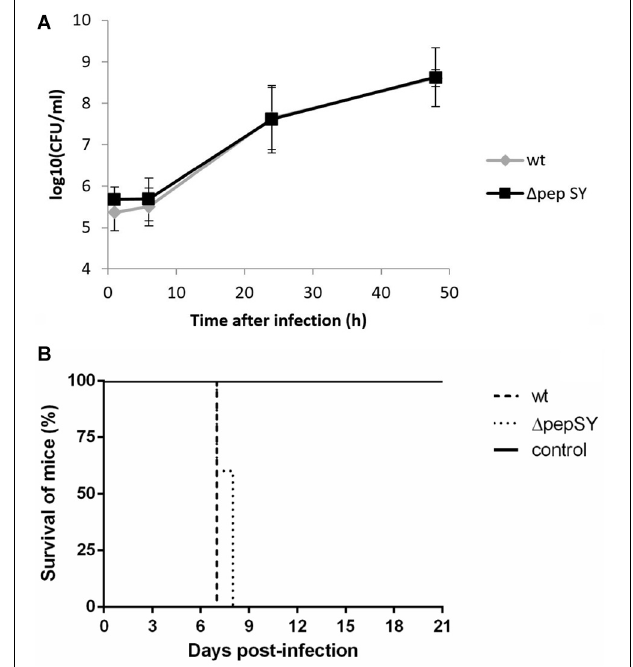
FIGURE 3 | Sensitivity of F. tularensis (cid:49) gapA , wtFSC200, and uvrA in to UV irradiation (A) and to H 2 O 2 (B) . For UV tolerance assay (A) , 10-fold serially diluted bacteria plated on McLeod agar were irradiated for various lengths of time under a 254 nm germicidal lamp. After UV irradiation the bacteria were cultivated at 37 ◦ C and the number of survivors was calculated by plate counts. For the uvrA in, no viable colonies could be detected when irradiated for 150 s. For the H 2 O 2 susceptibility assay (B) , bacteria in CDM were exposed to 1 mM H 2 O 2 for 2.5 and 5 h. The viable bacteria were determined by plating 10-fold serial dilutions. The values shown in both graphs represent means of triplicates ± SD. Three independent experiments were performed. Asterisks indicate statistically significant differences according to the Student’s two-tailed t -test: ** P < 0.01; *** P < 0.001 (comparing mutant strain with the wt strain).